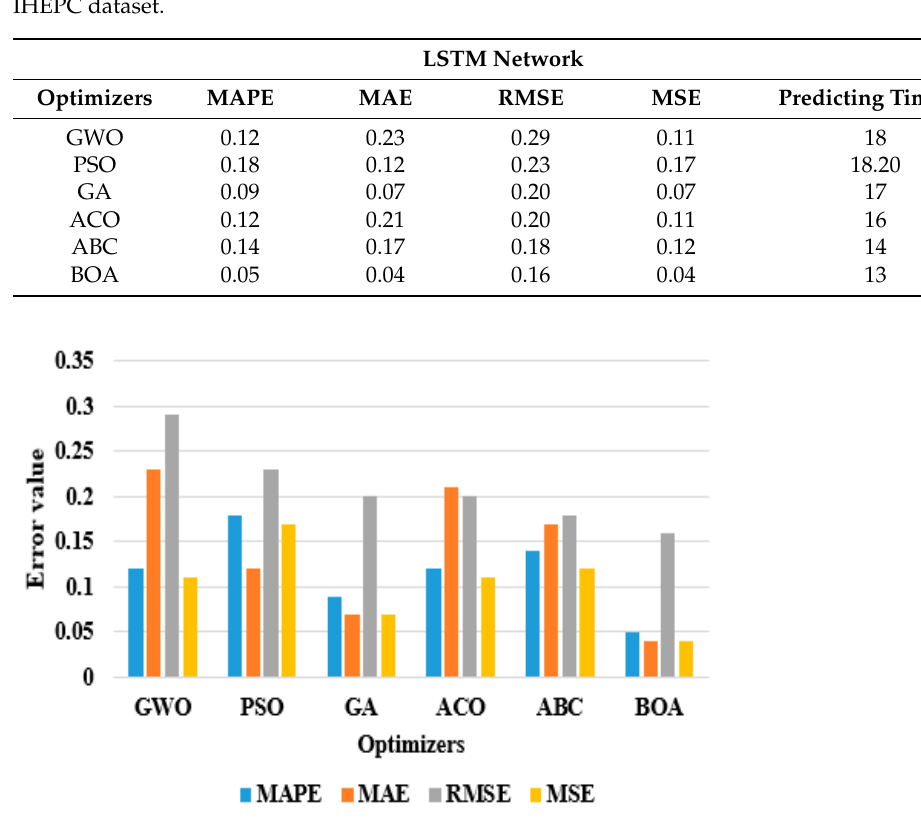
Figure 10. Graphical presentation of the dissimilar hyperparameter optimizers in the LSTM network on the IHEPC dataset.